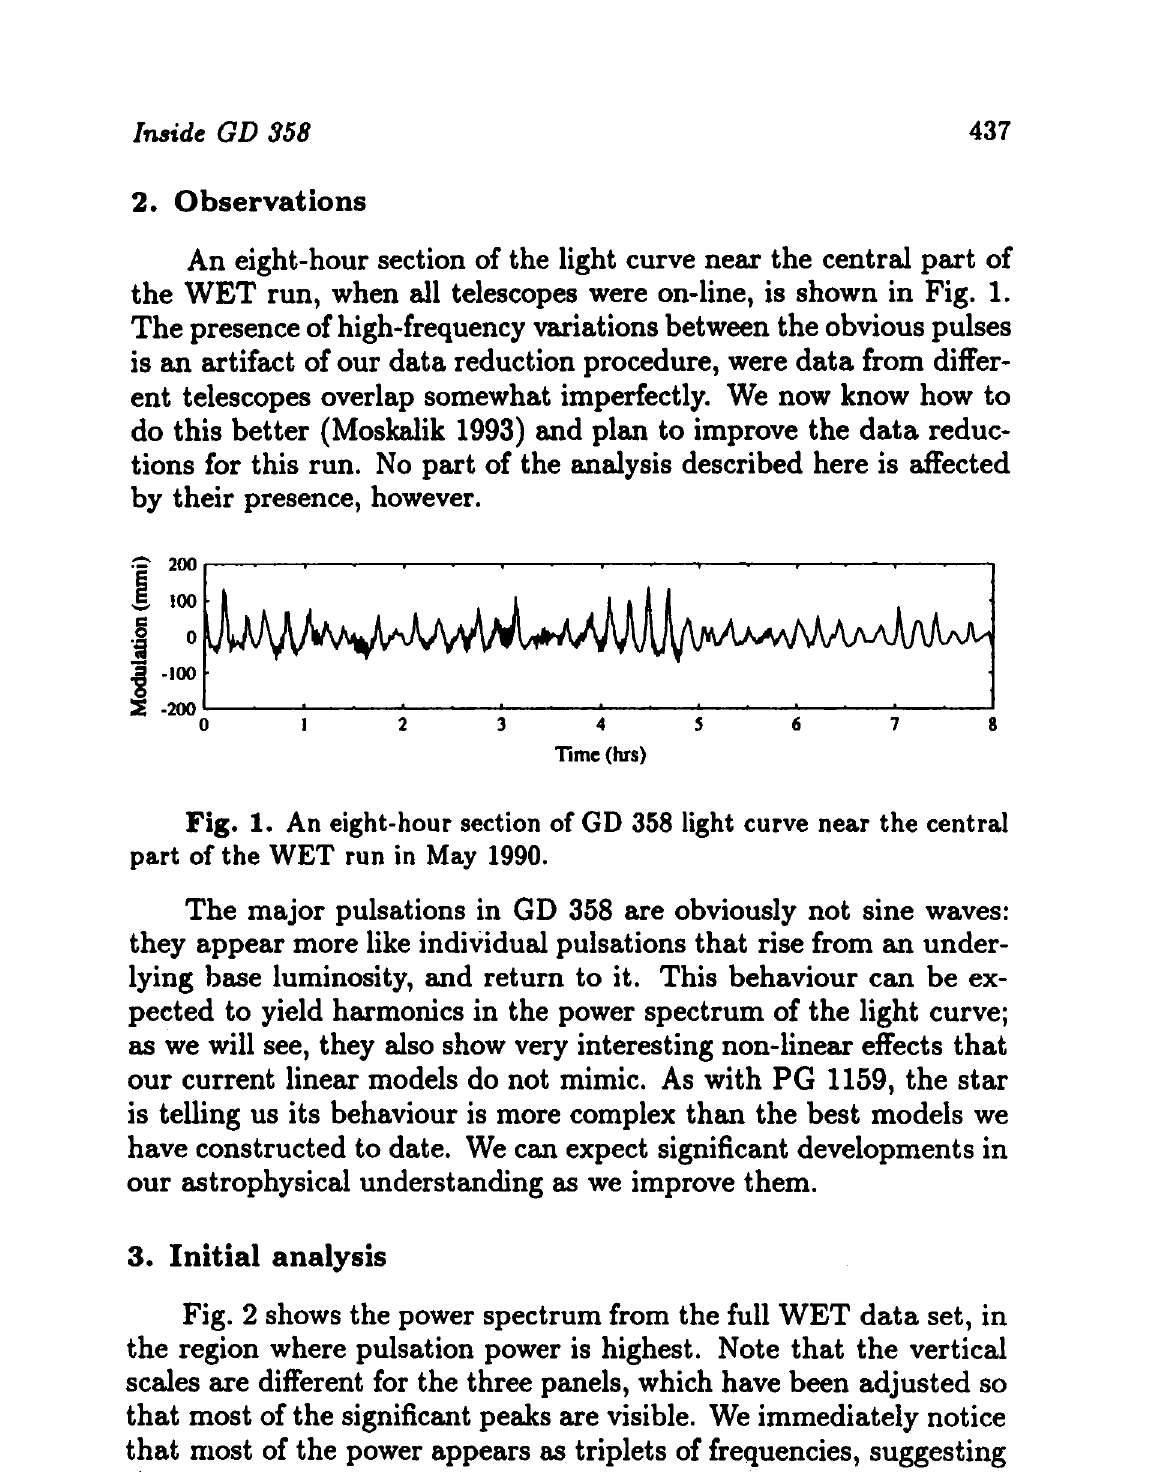
Fig. 1. An eight-hour section of GD 358 light curve near the central part of the WET run in May